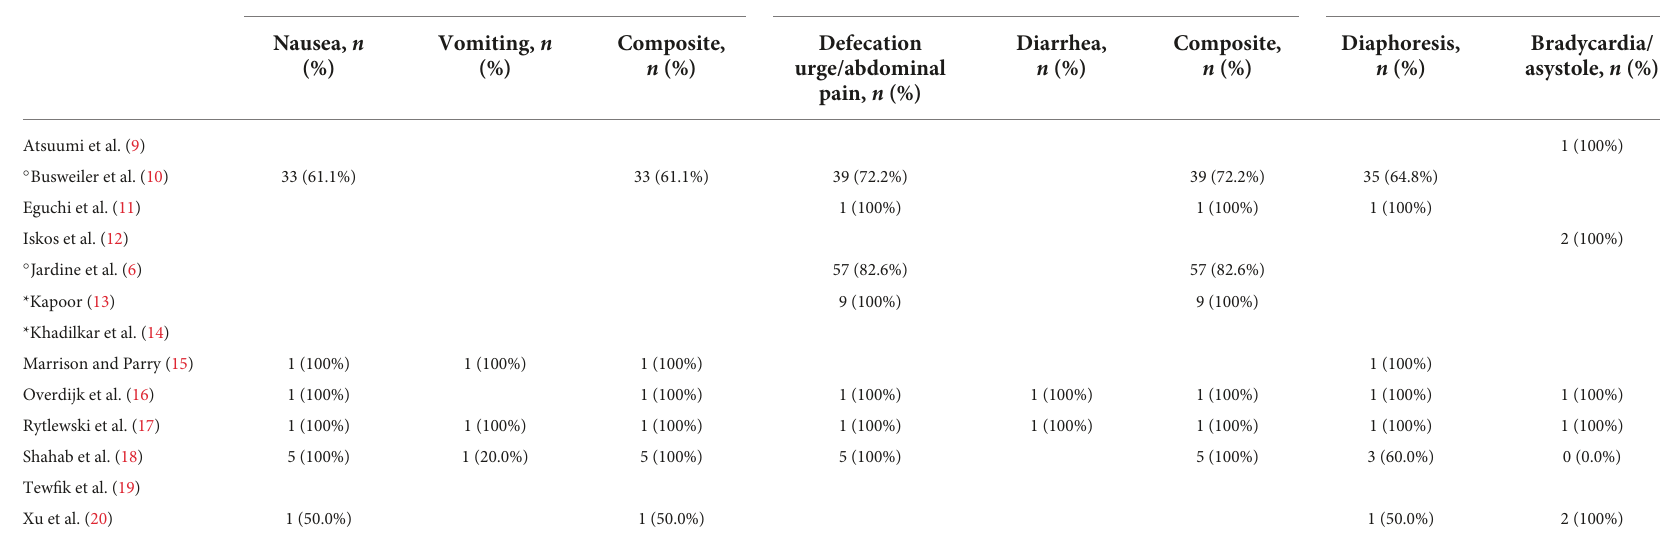
TABLE 4 Syncope-related symptoms in study